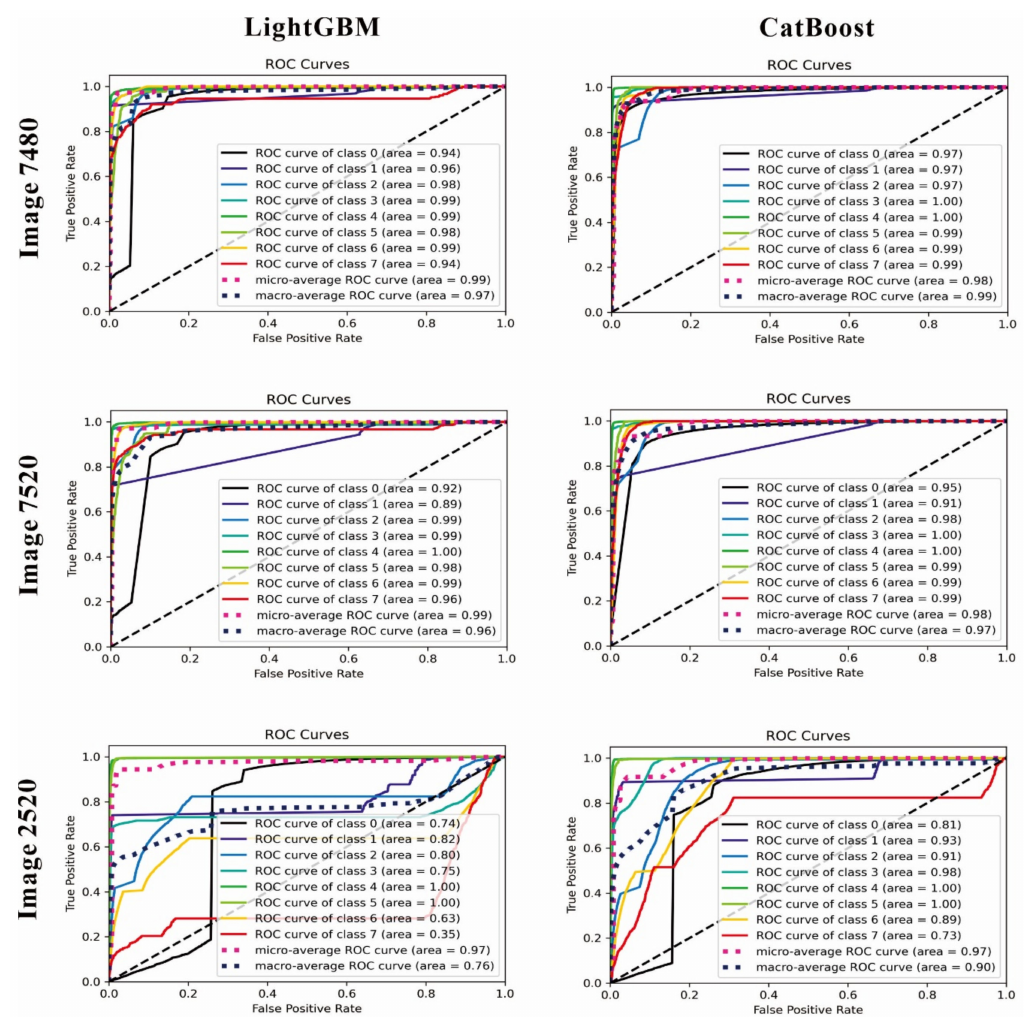
Figure 8. Multi-class ROC-AUC curves of GBDT classifiers in Case